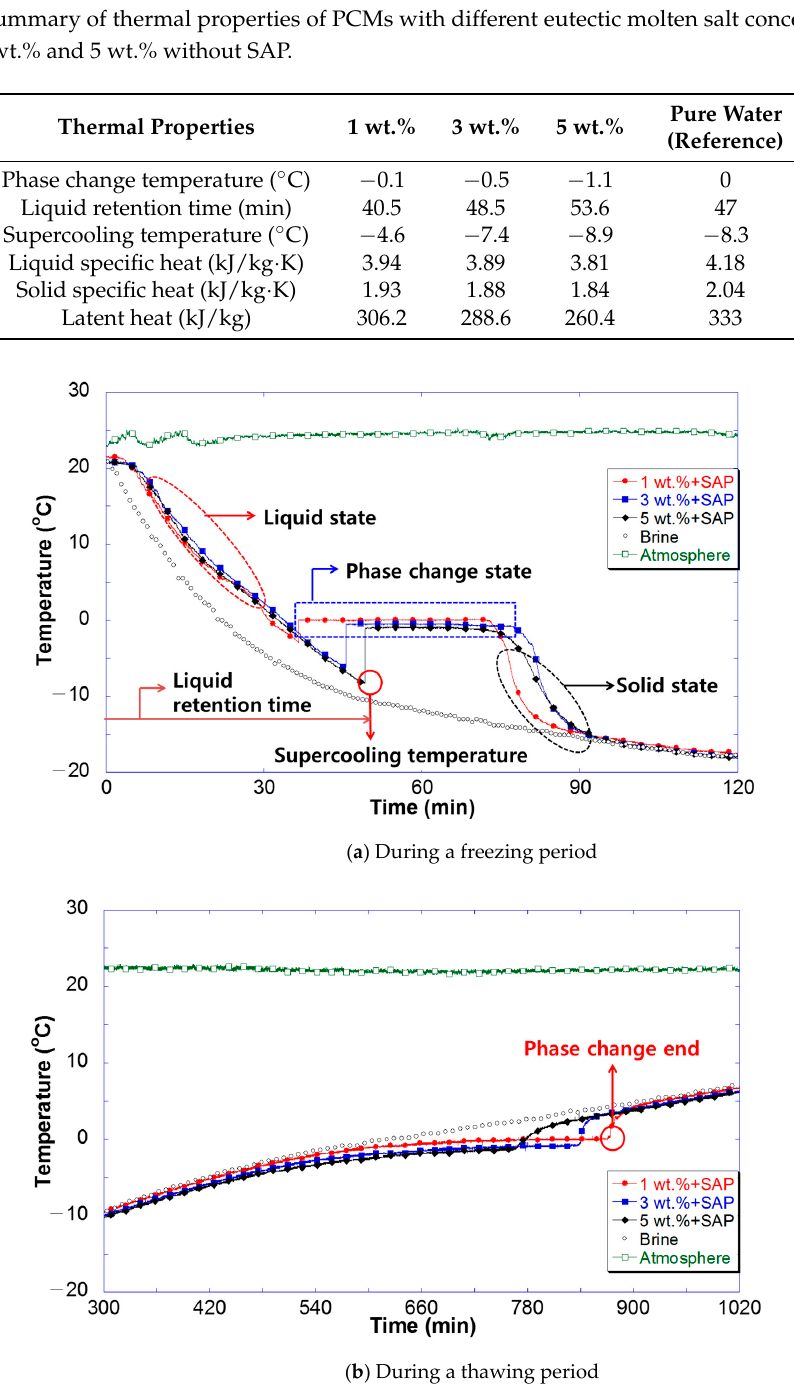
Figure 6. Measured temperature of PCMs with different eutectic molten salt concentrations; 1 wt.%, 3 wt.% and 5 wt.% with SAP.